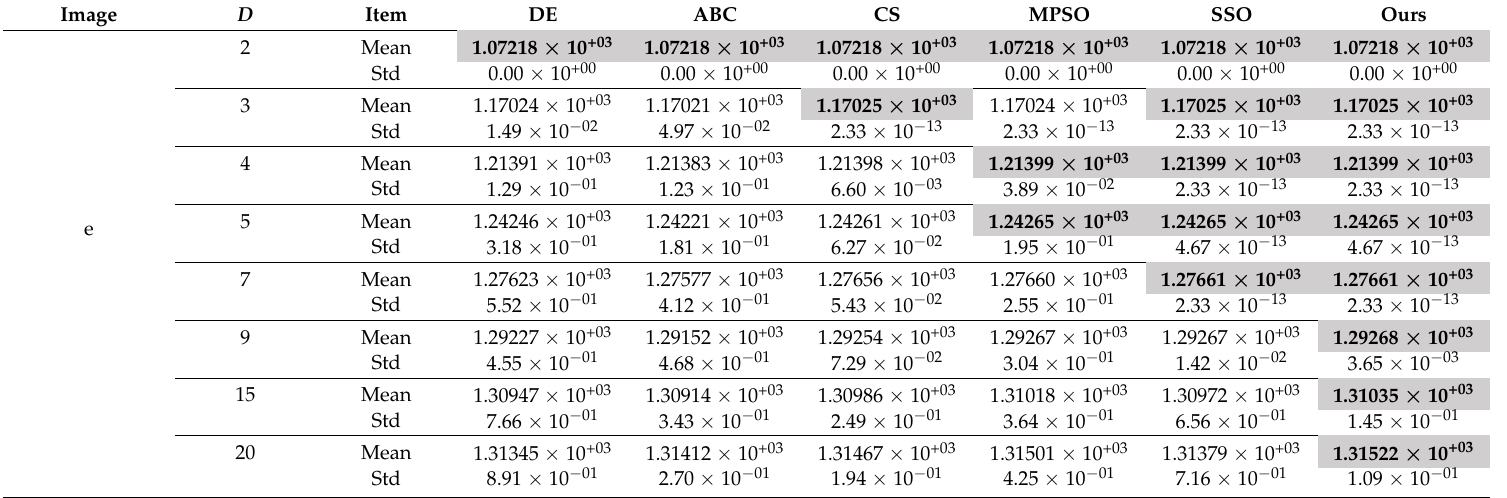
Note: the gray bacground highlights the best result on each